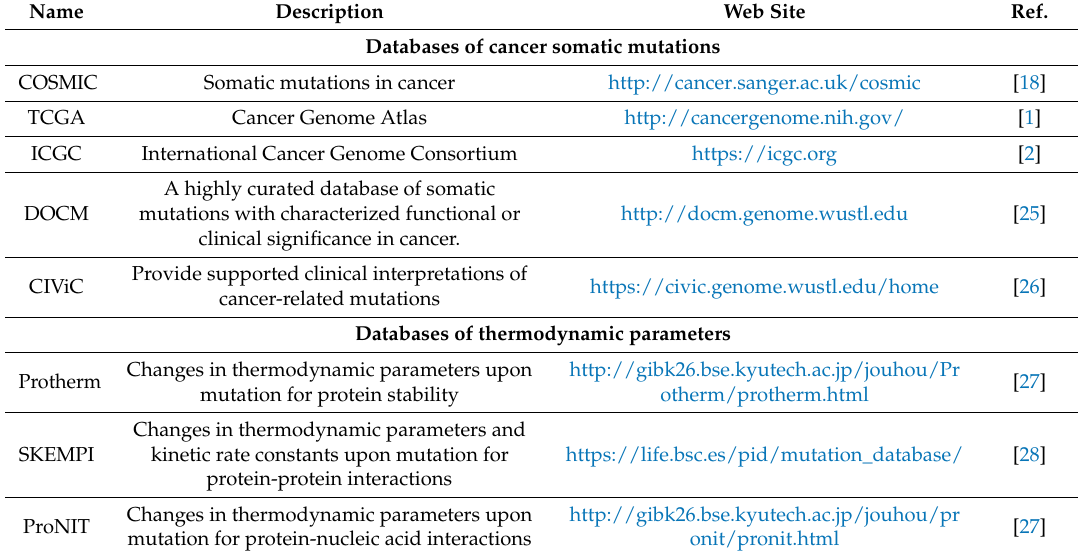
Table 1. Summary of data resources for cancer somatic mutations and development of computational tools for predicting the effects of mutations on protein stability, protein–protein interaction and protein–nucleic acid